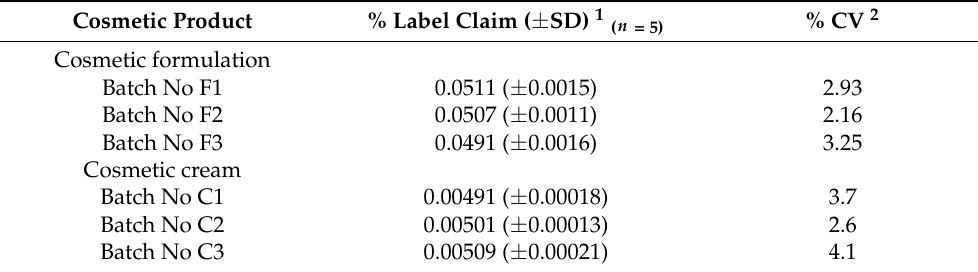
Table 4. Quantitation of acetyl hexapeptide-8 in cosmetic formulation and cosmetic